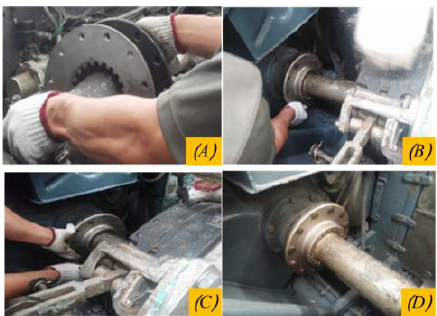
Figure 25. The assembly of reduction gear ( A ), tightening of bolts on connected plate ( B ), position adjustment of connected plate ( C ), finish of connected plate assembly ( D ).